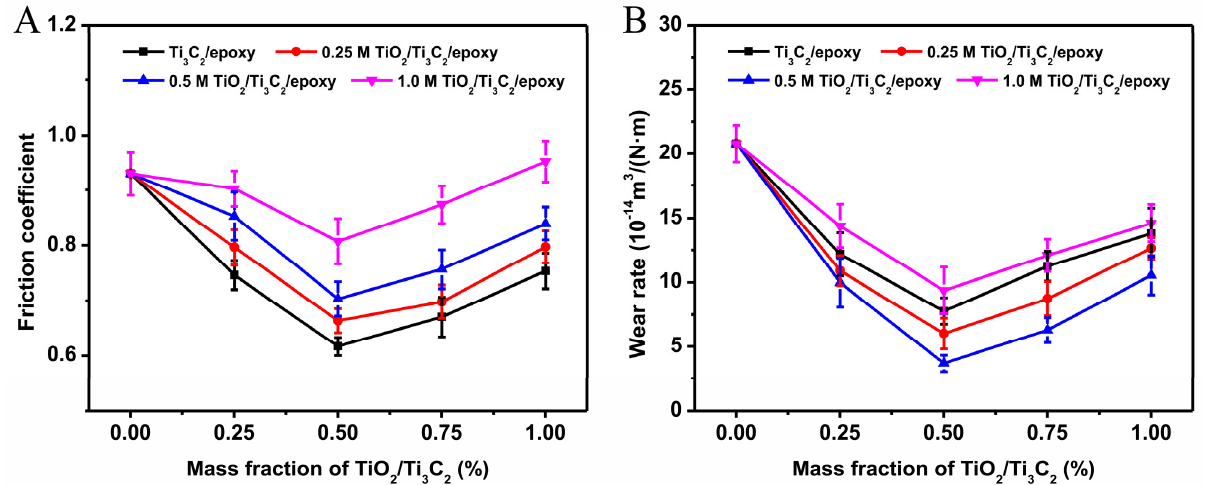
Figure 3. ( A )Friction coefficient and ( B ) wear rate of TiO 2 /Ti 3 C 2 /epoxy nanocomposites with different mass friction under a normal load of 8 N.